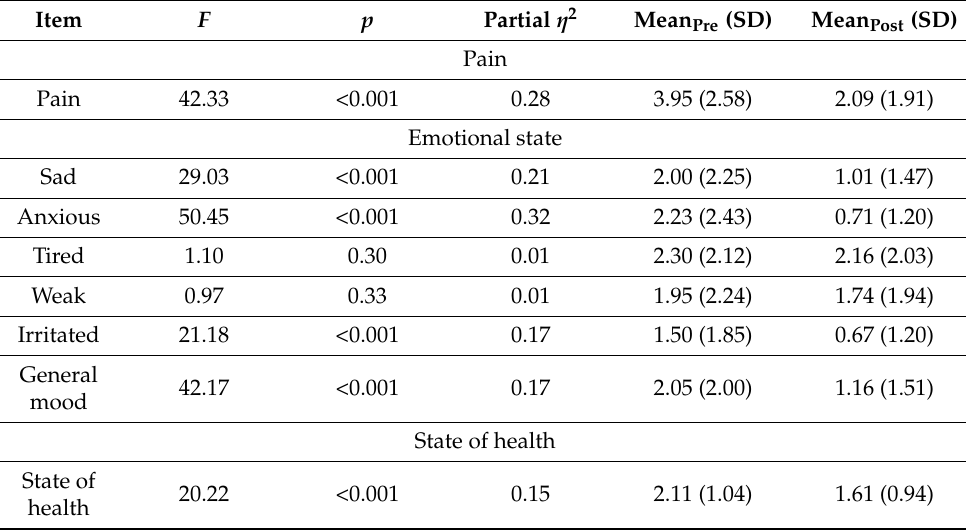
Table 3. Pre- and postoperative indicators for sensitivity to changes in emotional